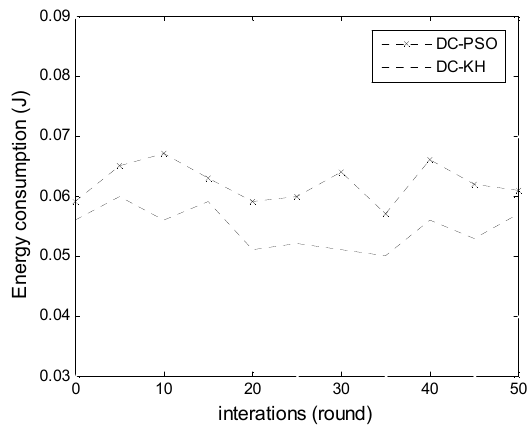
Figure 4. Energy consumption comparison chart of the vice cluster head.